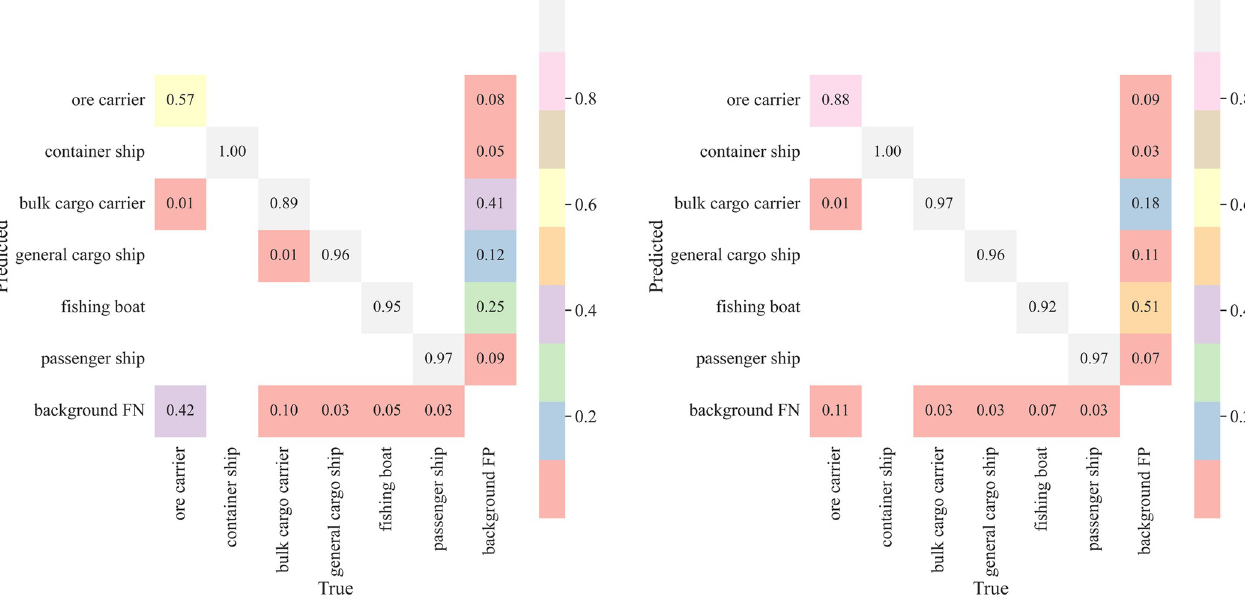
PLOS ONE | https://doi.org/10.1371/journal.pone.0283932 April 6, 2023 17 /